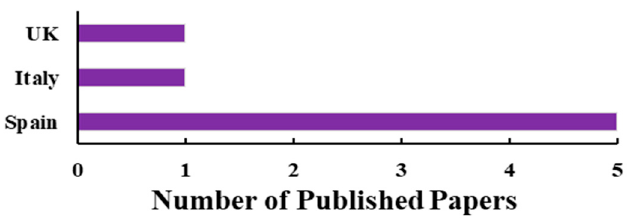
Figure 4. Bar graphs represent the country-wise unmanned aerial vehicle (UAV)-based SIF studies published until 2019. Violet represents the European continent. Note: the first author and/or corresponding author (if different) affiliations were used as the main criterion for defining the country of origin of the paper.